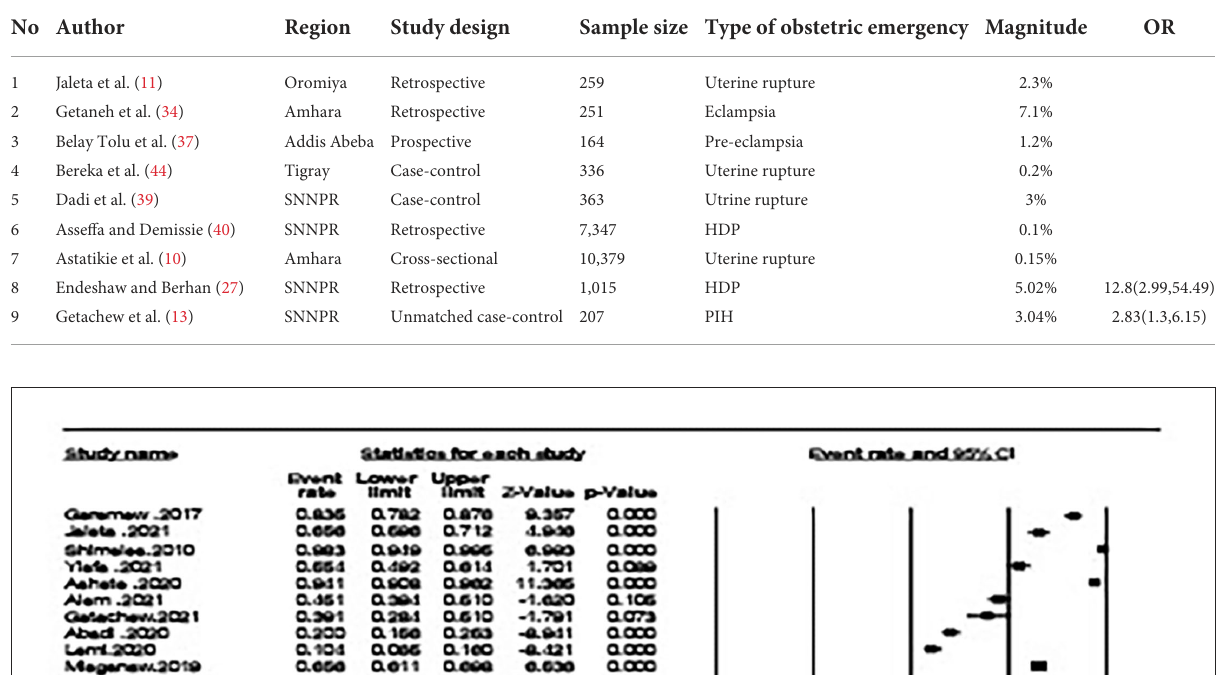
TABLE 2 Obstetric emergencies and maternal mortality.